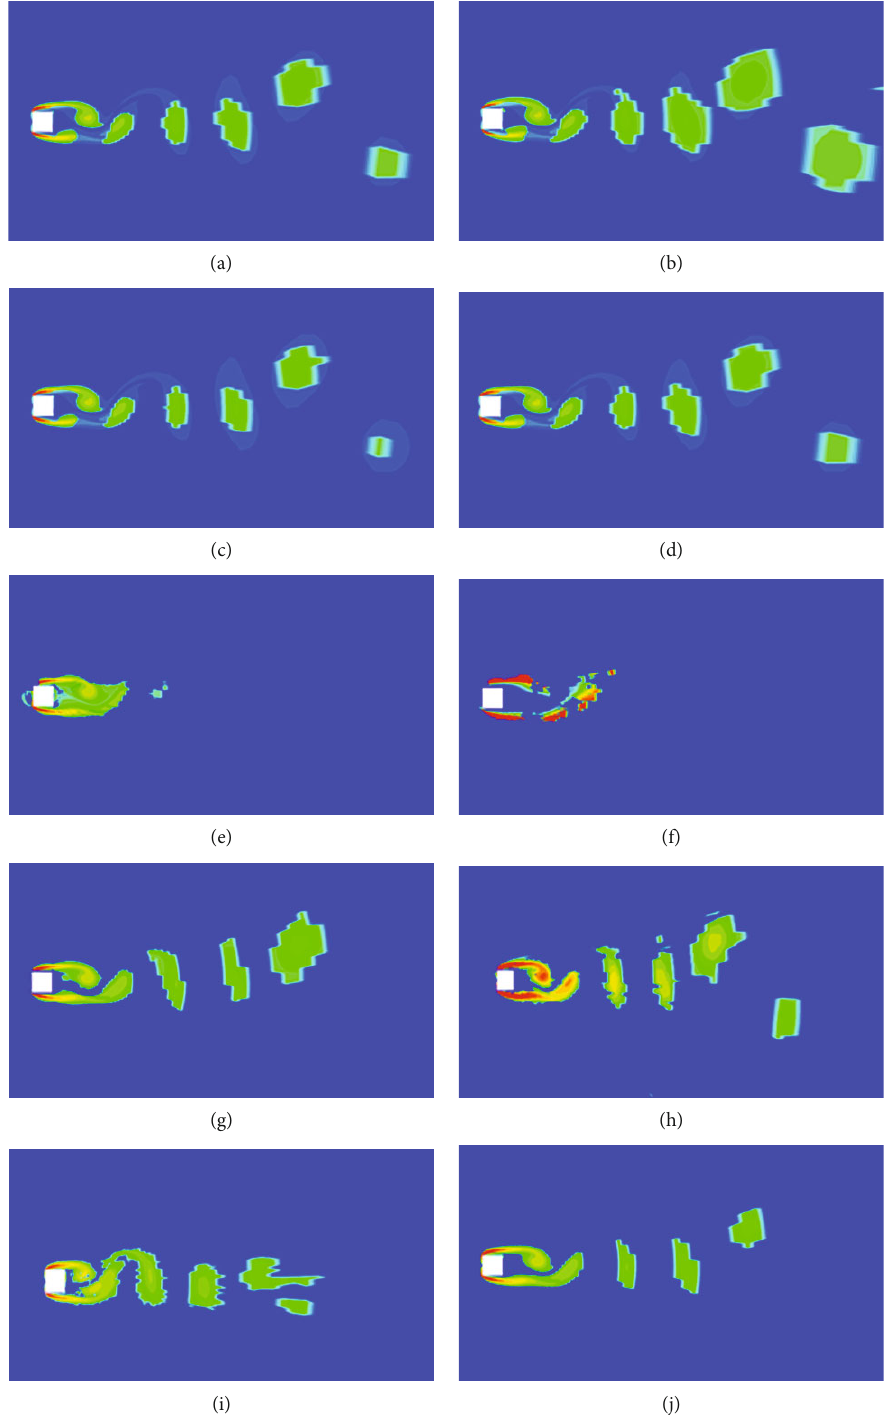
Figure 6: Visualization results of di ff erent methods in 101 × 761 square fl ow fi eld. We use vorticity to colour the fl ow fi eld. The vorticity used here is the dot product of the original vorticity value of the fl ow fi eld data and the predicted